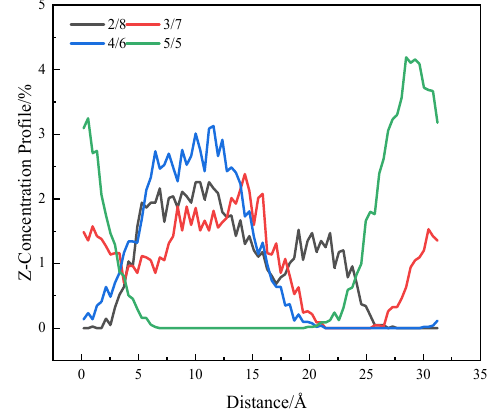
Figure 9. Wetting of SBS in asphalt.